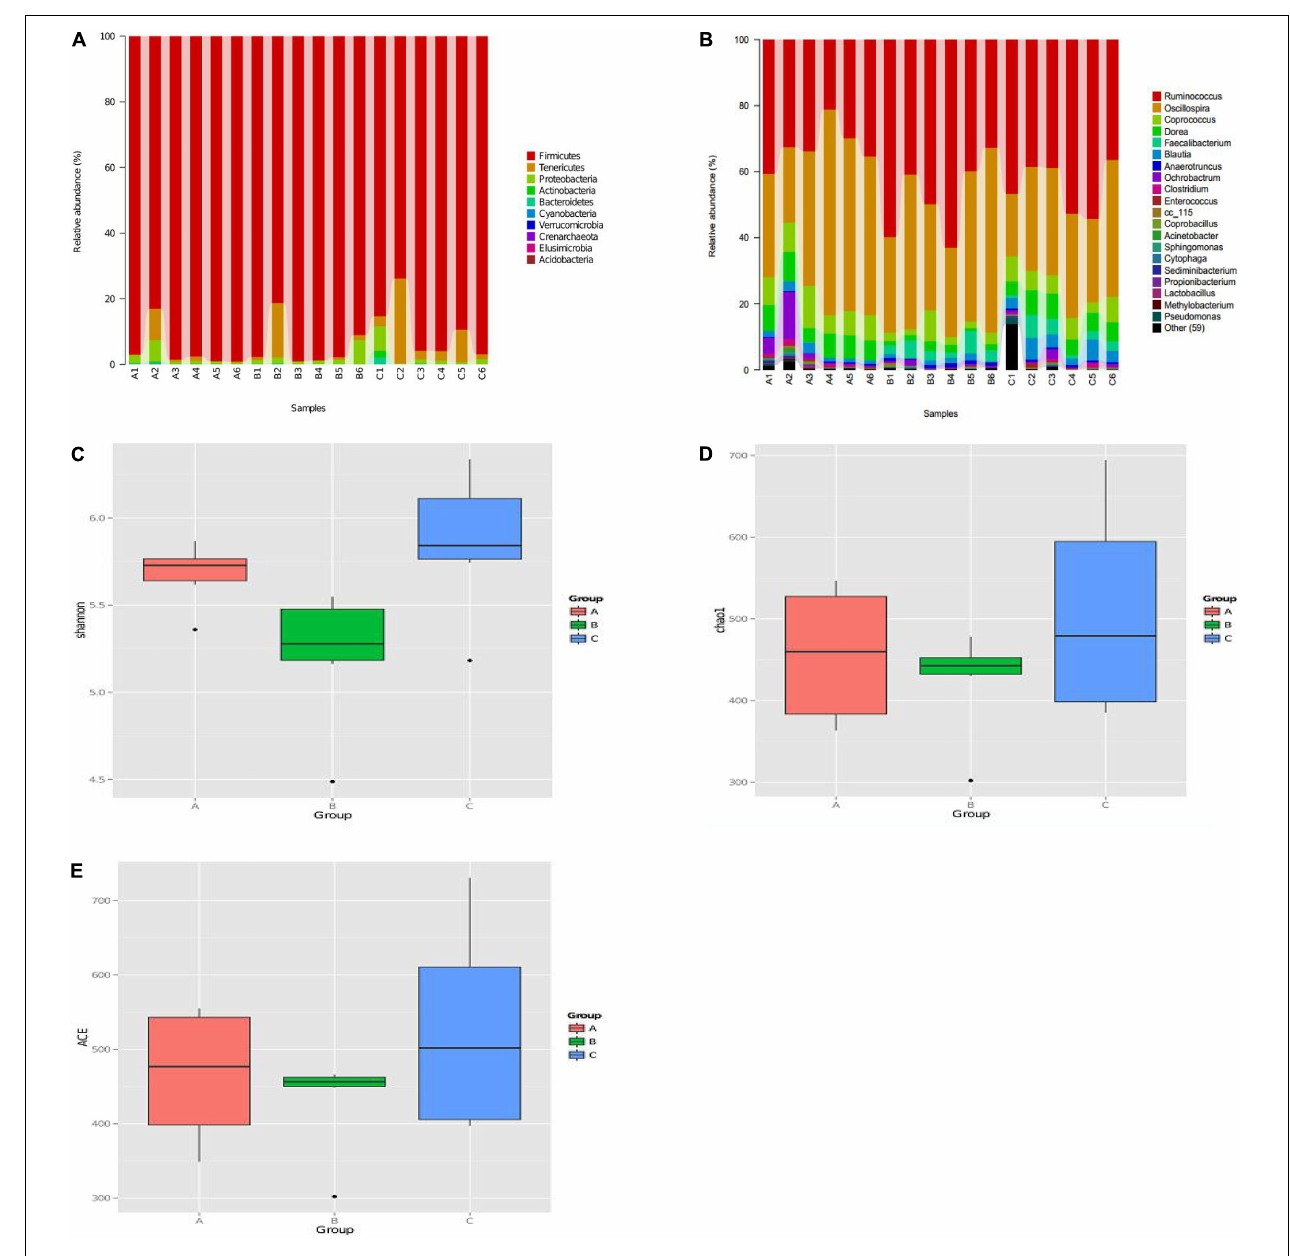
FIGURE 6 | The diversity and composition of the bacterial communities were determined by α diversity according to Personalbio’s recommendations. (A) Relative abundance of the most abundant bacterial phyla. (B) Relative abundance of the most abundant bacterial genus. The diversity of the bacterial communities were determined by Shannon index (C) , Chao1 index (D) , ACE index (E) . (A–C) Represented sample of NC, PC, and EXP group. NC, the negative control group; PC, the positive control group; EXP, C. butyricum + S. enteritidis